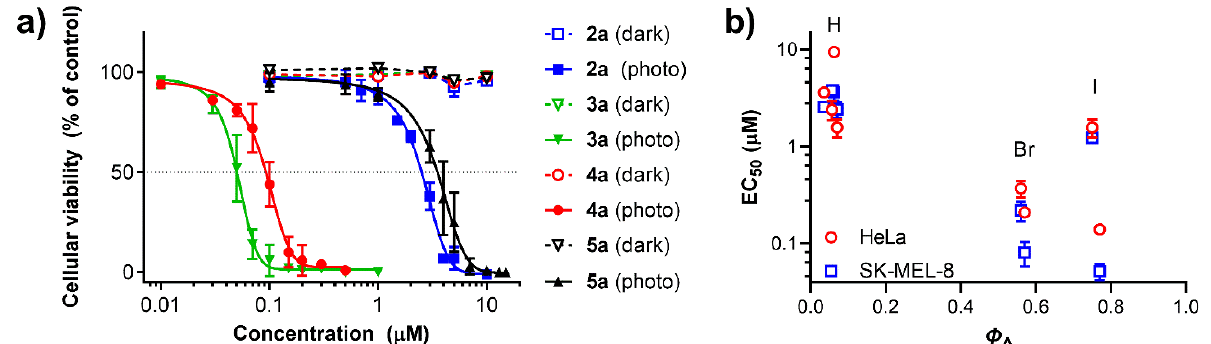
Figure 2. ( a ) Photodynamic activity (full lines, full symbols) and dark toxicity (dashed lines, empty symbols) of 2a – 5a on SK-MEL-28 cell line. At least four independent experiments each in triplicate were performed. Irradiation conditions: λ > 455 nm, 15.3 mW cm − 2 , 15 min, 13.7 J cm − 2 ; ( b ) dependence of EC 50 values of all investigated compounds ( 2a , b – 5a , b ) on their Φ ∆ values. Red circle (HeLa), blue square (SK-MEL-28).